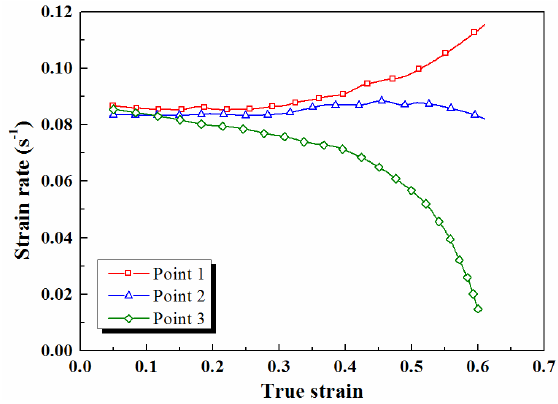
Figure 6. Strain rates’ evolution.